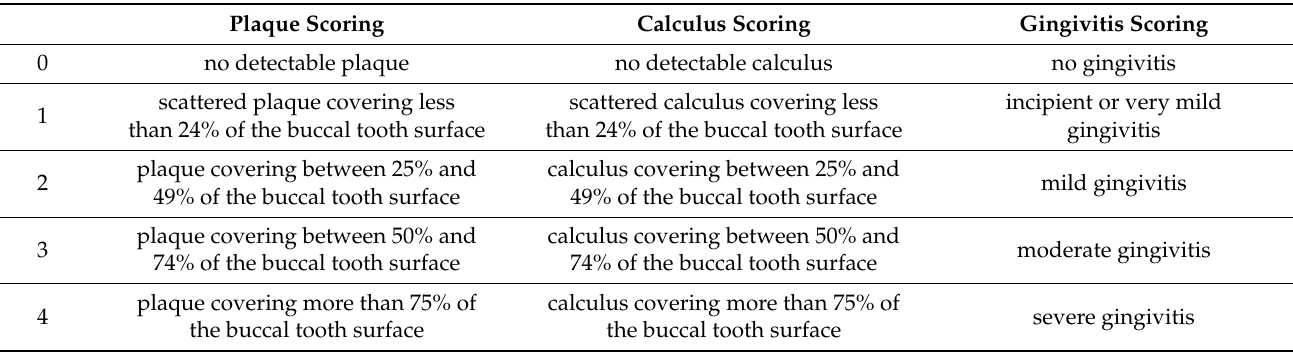
Table 1. Scoring criteria of Plaque, Calculus, and Gingivitis index from 0 to 4.